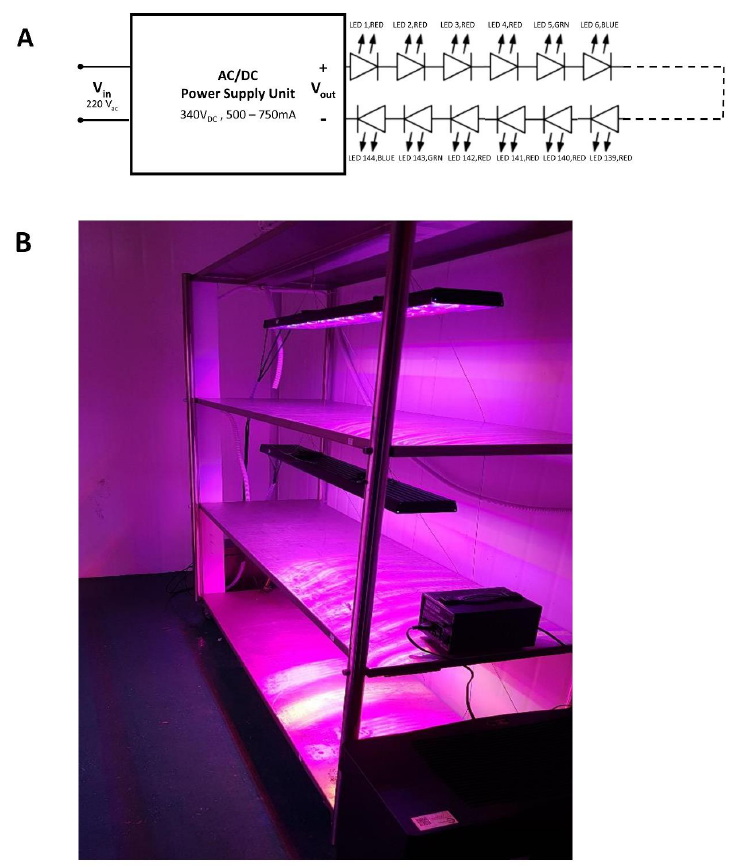
Figure 1. Artificial lighting fixture. ( A ) Lighting system circuit. ( B ) Actual lighting fixture setup in growth room.